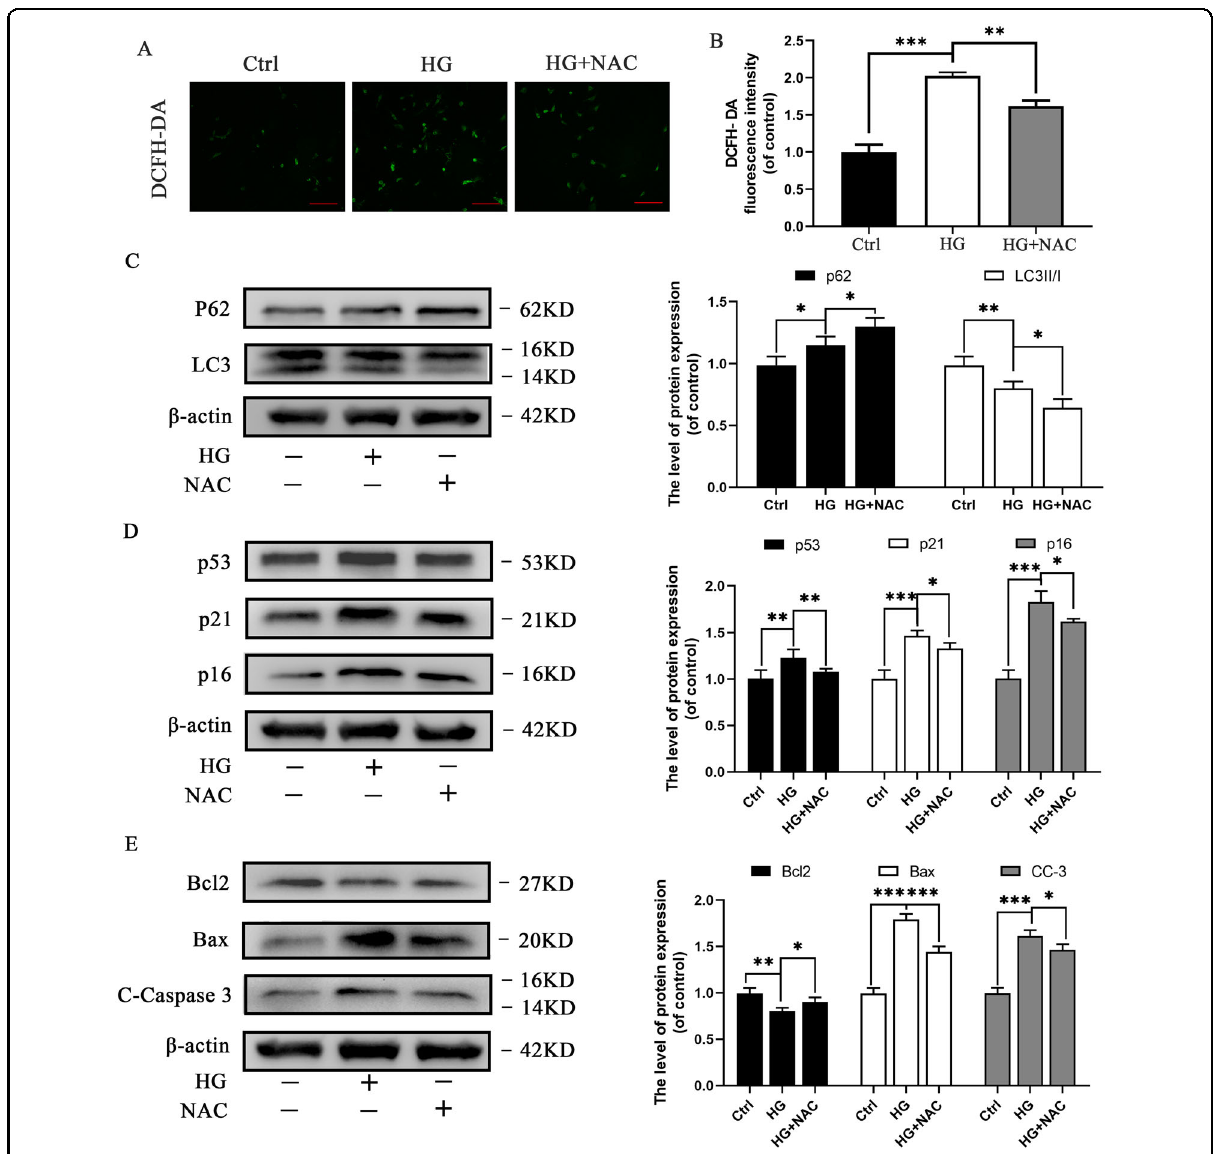
Fig. 3 Elimination of oxidative stress suppresses autophagy and inhibits apoptosis and senescence in chondrocytes. A Representative micrographs of DCFH-DA staining representing variations in ROS levels upon treatment with NAC. Scale bar = 50 μ M. B Decrease in DCFH-DA fl uorescence intensity in HG-stimulated chondrocytes upon treatment with NAC. C Western blot results and quanti fi cation analyses of p62 and LC3 in various treatment groups. D Western blot results and quanti fi cation analyses of p53, p21, and p16 in various treatment groups. E Western blot results and quanti fi cation analyses of Bcl2, Bax, and cleaved caspase-3 in various treatment groups. Data are presented as means ± SD ( n = 5). * P <0.05, ** P <0.01 , and *** P